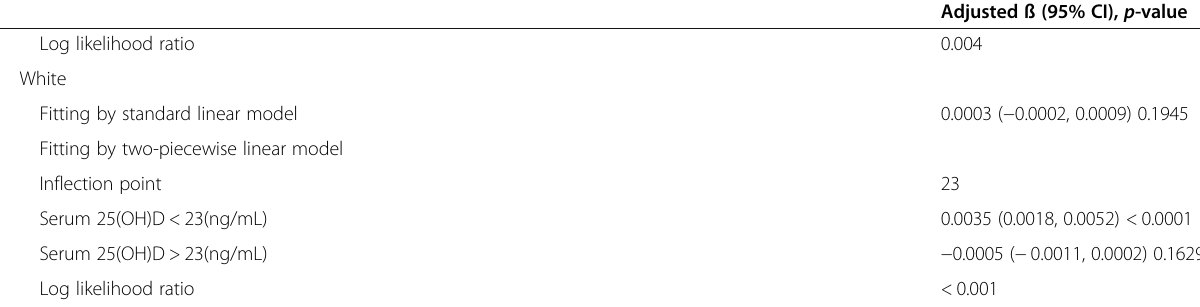
Table 4 Threshold effect analysis of serum calcium and 25(OH)D on total bone mineral density by using two-piecewise linear regression (Continued)